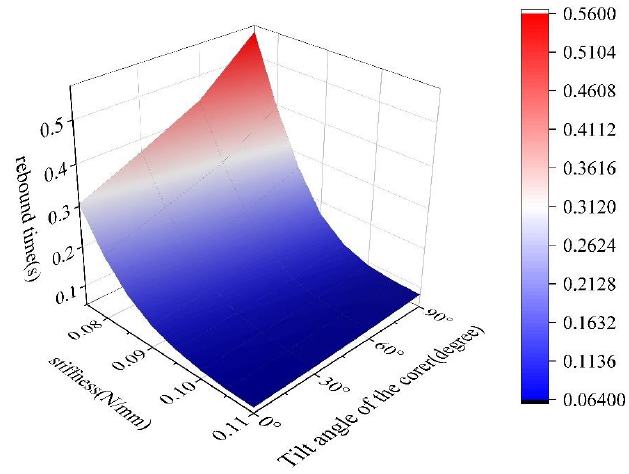
Figure 9. Springback time law for different stiffness levels corresponding to sleeves under several inclination angles.